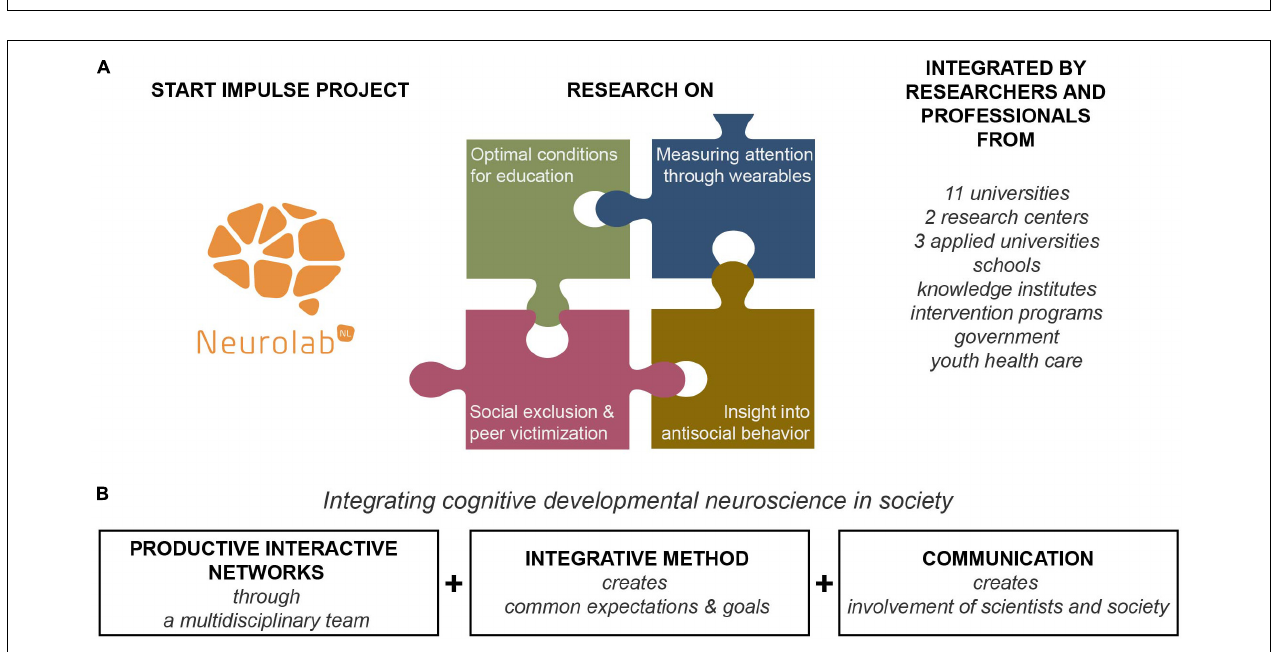
FIGURE 1 | Overview of the NeurolabNL Startimpulse project. (A) In four overarching projects, scientists and societal partners worked together to integrate research on optimal conditions of for education (with a focus on motivation and language learning), measuring attention through wearables, insight into antisocial behavior and social exclusion & peer victimization (B) The NeurolabNL Startimpulse project integrated cognitive developmental neuroscience in society by forming productive interactive networks, using an integrative method and devoting enough resources to